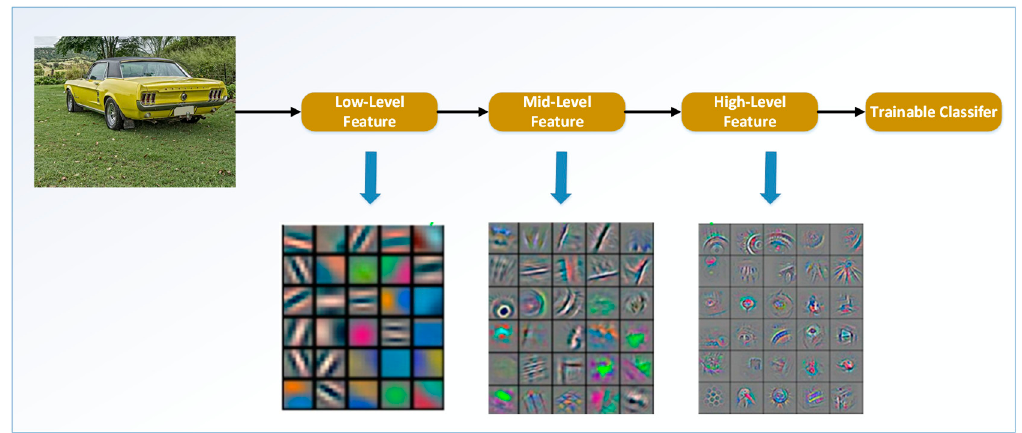
Figure 1. Convolution kernel of different rank features extracted by convolution neural network (CNN) model.